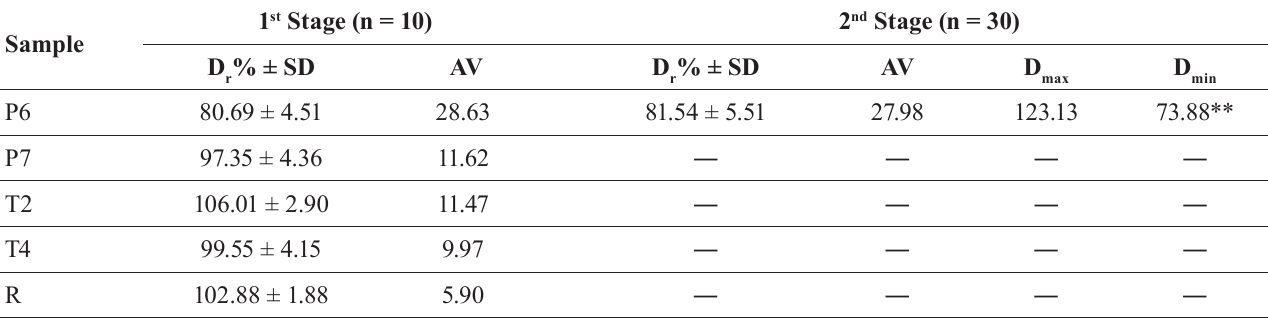
TABLE V - A mount of furosemide as a percentage of the labeled dose (D variation test